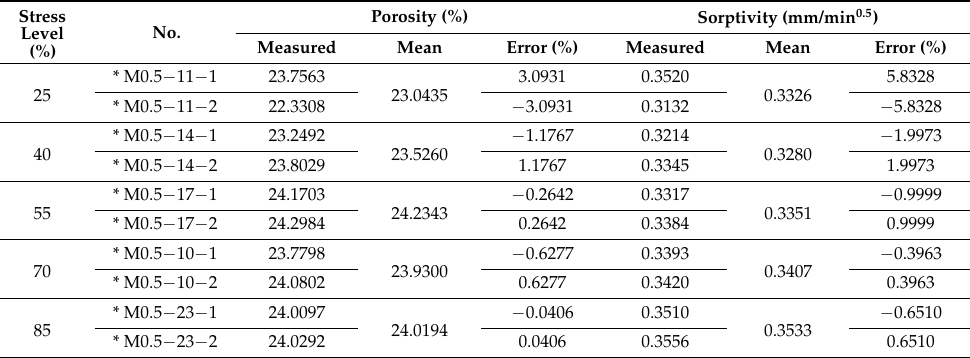
Table 3. Measured porosities and sorptivities of damaged mortar specimens (w/c = 0.5).